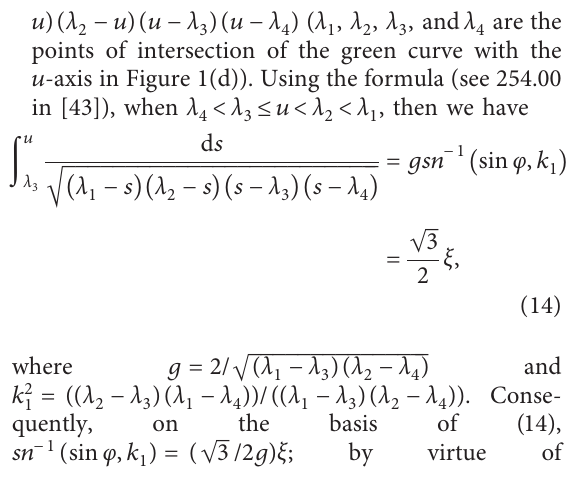
� √ � √ � √ 3 , (b) c � 3, l � 3 , (c) c � − 3, l � 3 , and (d) c � 0 . 2, l �